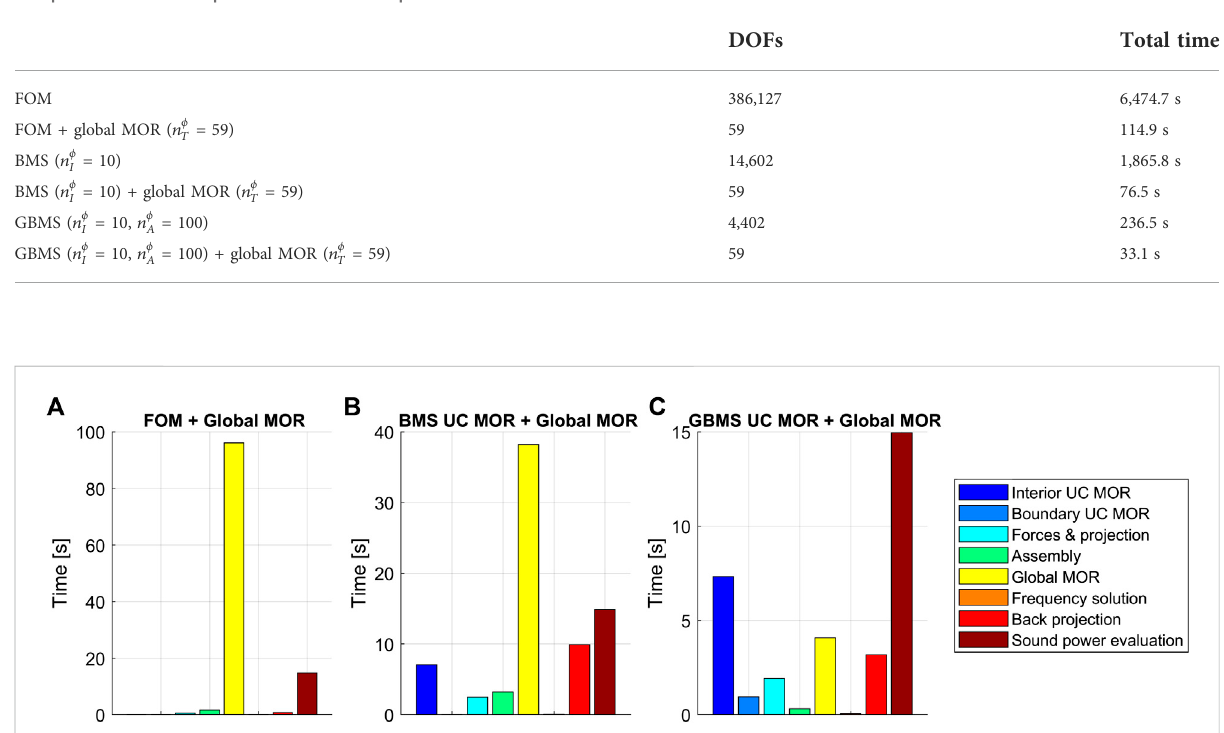
TABLE 5 Overview of FOM, BMS and GBMS UC based fi nite LRM plate model sizes for the clamped fi nite plate assembly of 5 × 5 UCs and total computational times required for the STL computations.